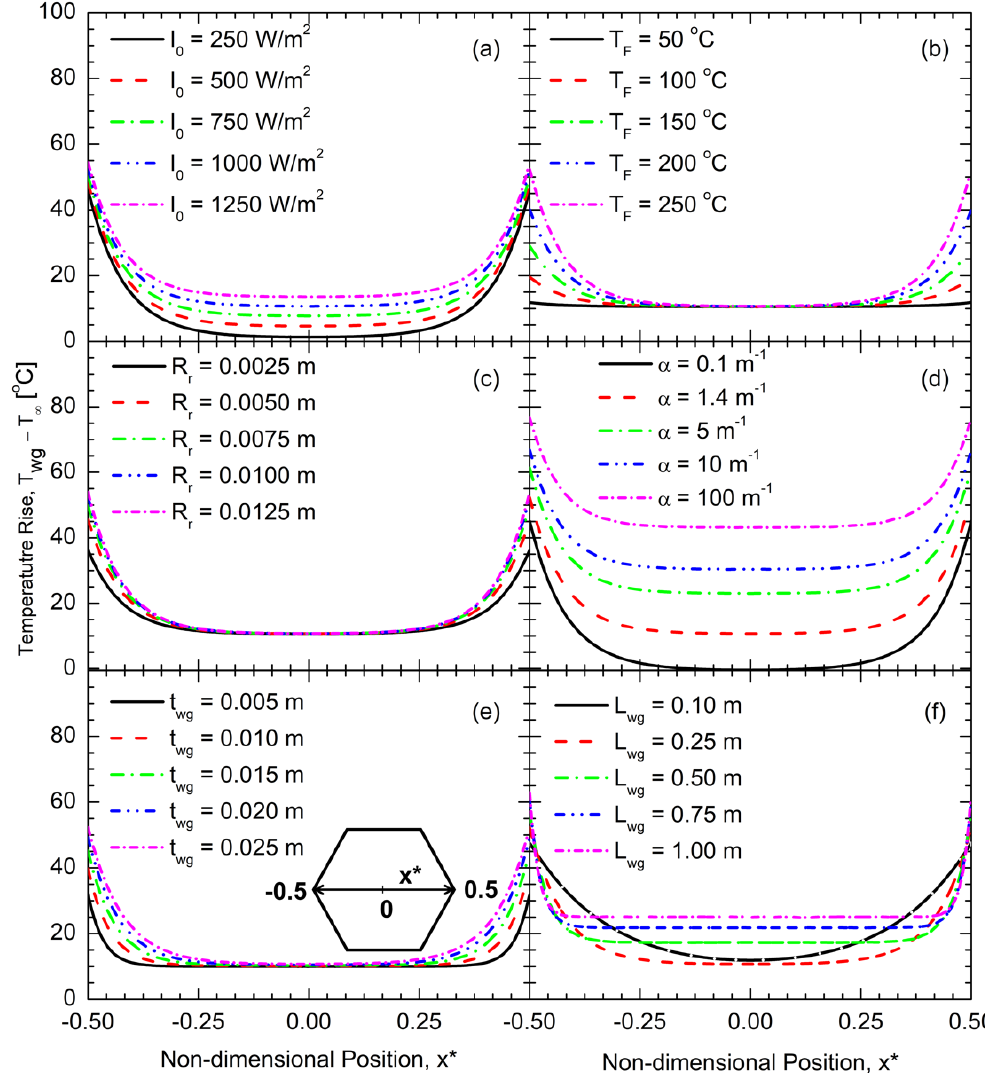
Figure 3. Influence of ( a ) incident solar radiation ( I 0 ), ( b ) HTF Temperature ( T F ), ( c ) Receiver radius ( R r ), ( d ) absorption coefficient ( α ), ( e ) thickness of waveguide ( t wg ), and ( f ) length of waveguide ( L wg ) on the spatial temperature rise distribution in a hexagonal waveguide solar concentrator.